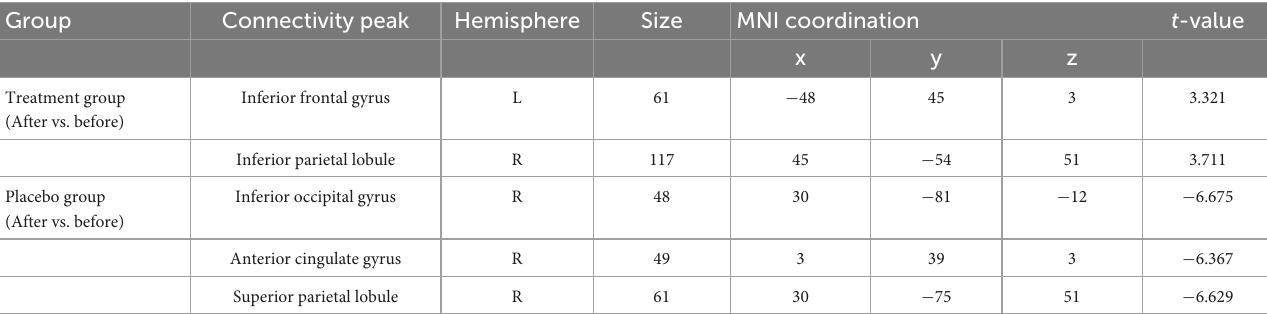
TABLE 3 Seed-based dynamic functional connectivity group comparison. Group Connectivity peak